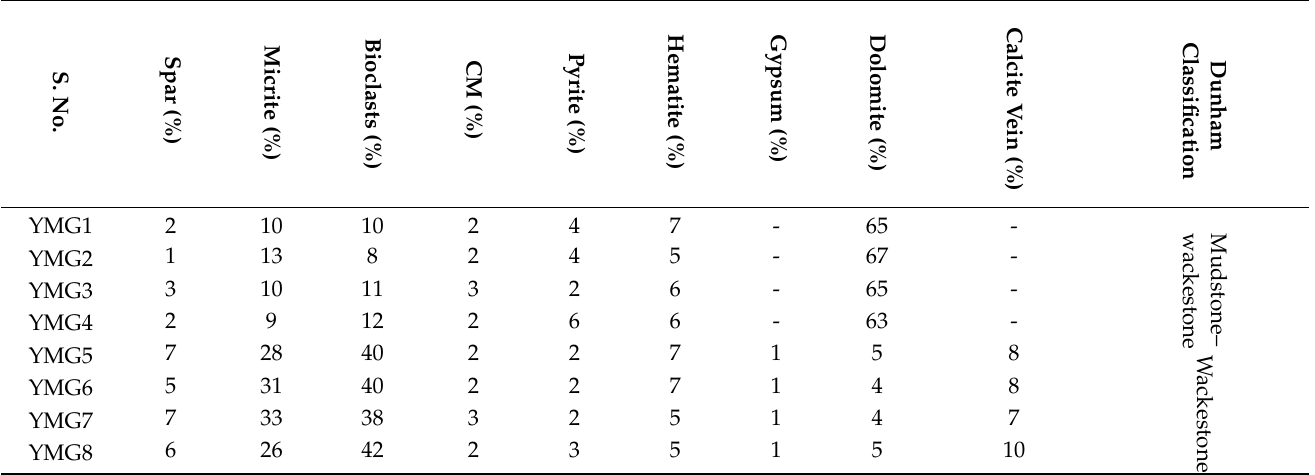
Table 1. Modal mineralogical composition of the Early–Middle Eocene carbonate rocks of Yadgaar Section. (CM-carbonaceous material). Section. (CM-carbonaceous